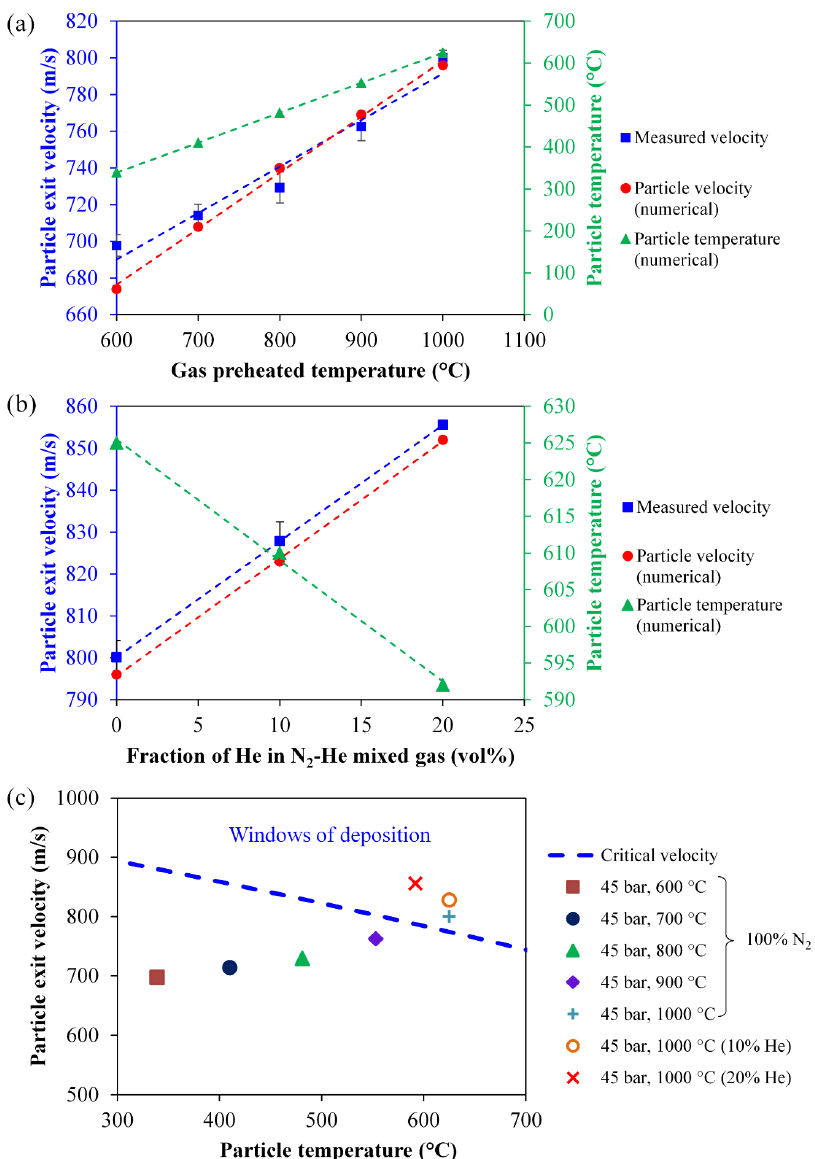
Figure 4. ( a , b ) The particle exit velocity as a function of ( a ) gas preheated temperature at a constant Figure 4. pressure of 45 bar and ( b ) fraction of He gas in N 2 -He mixture (vol.%) at 45 bar and 1000 ◦ C; and ( c ) windows of deposition based on particle velocity and temperature. The numerical calculations by Kinetic Spray Solutions (KSS) software were based on the particle size of 33 µ m. It is to be noted that the velocity measurements for 45 bar, 600 and 700 ◦ C were used as a comparison and the coatings were not actually